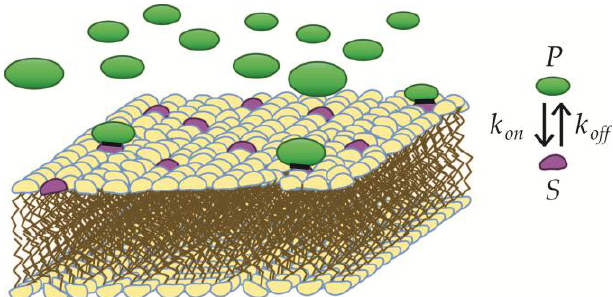
Figure 2. Adsorptive binding of protein to independent binding sites. Adsorptive binding of proteins ( green ) to specific binding sites ( purple ) in the membrane is illustrated. The binding sites are assumed to be independent, and the binding is characterized by an on-rate ( k on ) and an off-rate ( k off ).